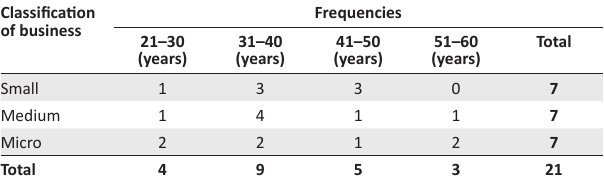
TABLE 5: Age of owners or managers.